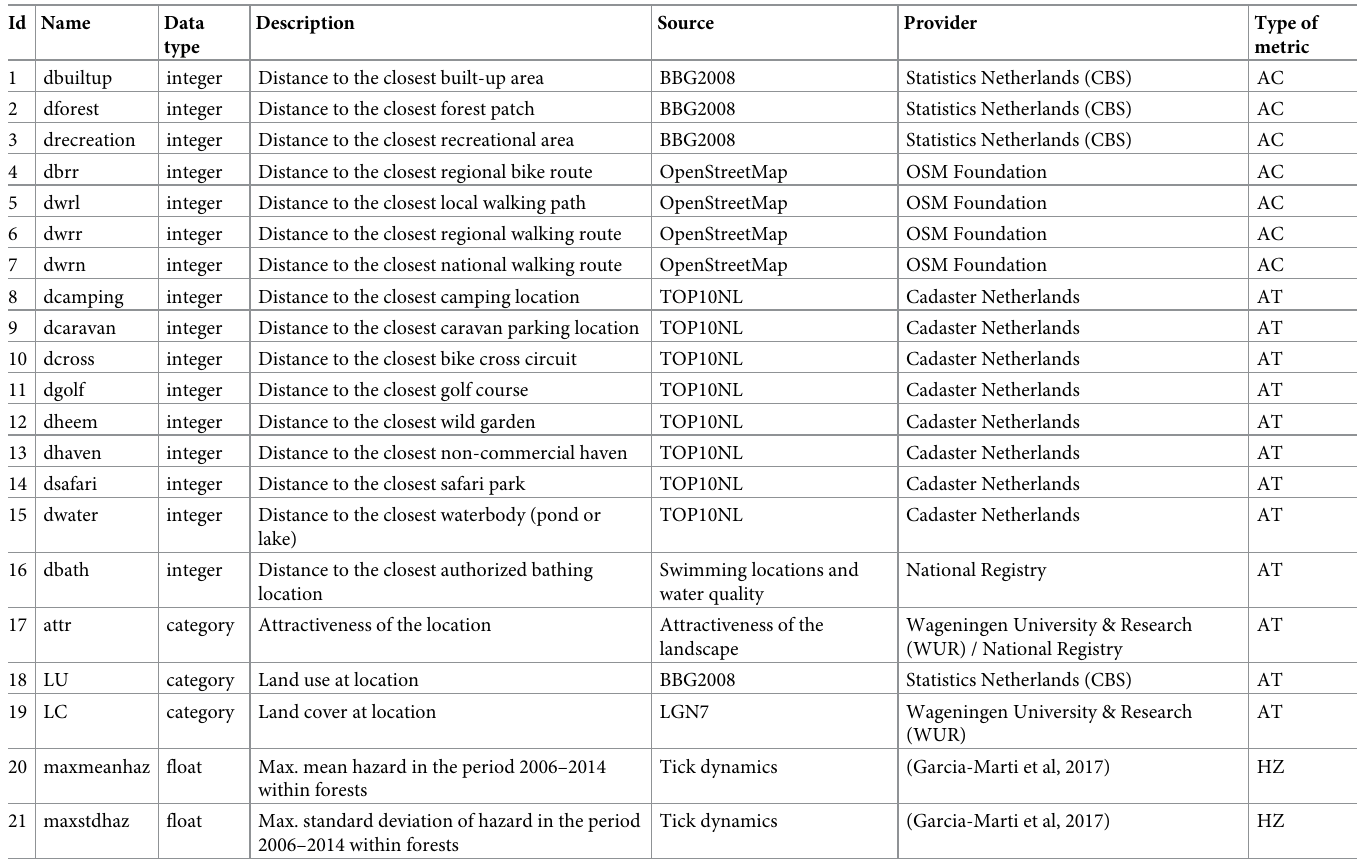
Table 1. Features used in this